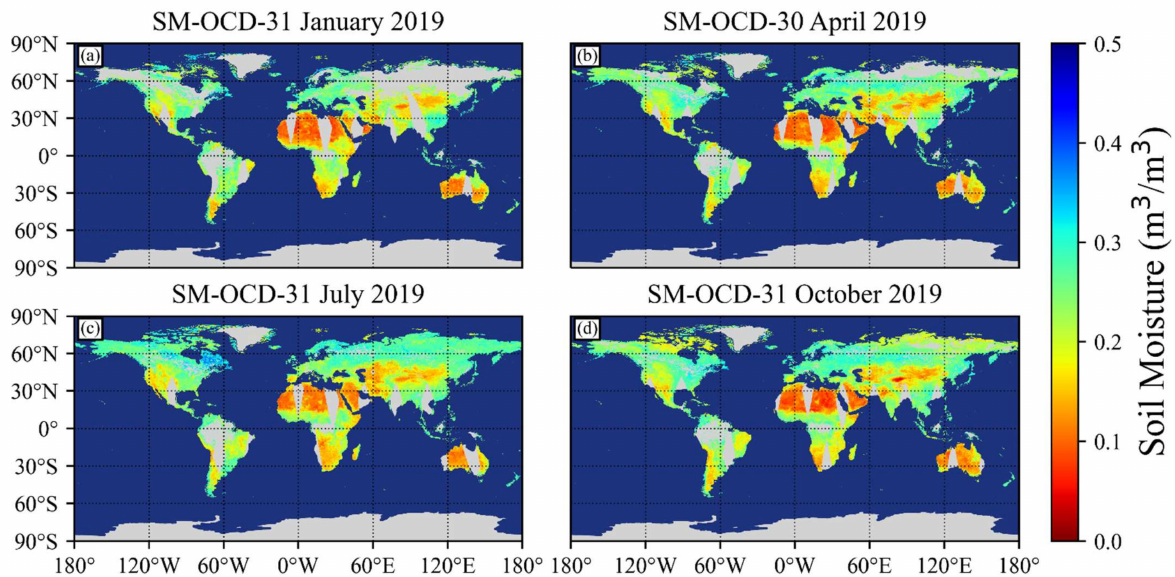
Figure 5. Global soil moisture maps retrieved based on OCD on: ( a ) 31 January; ( b ) 30 April; ( c ) 31 July; and ( d ) 31 October 2019.